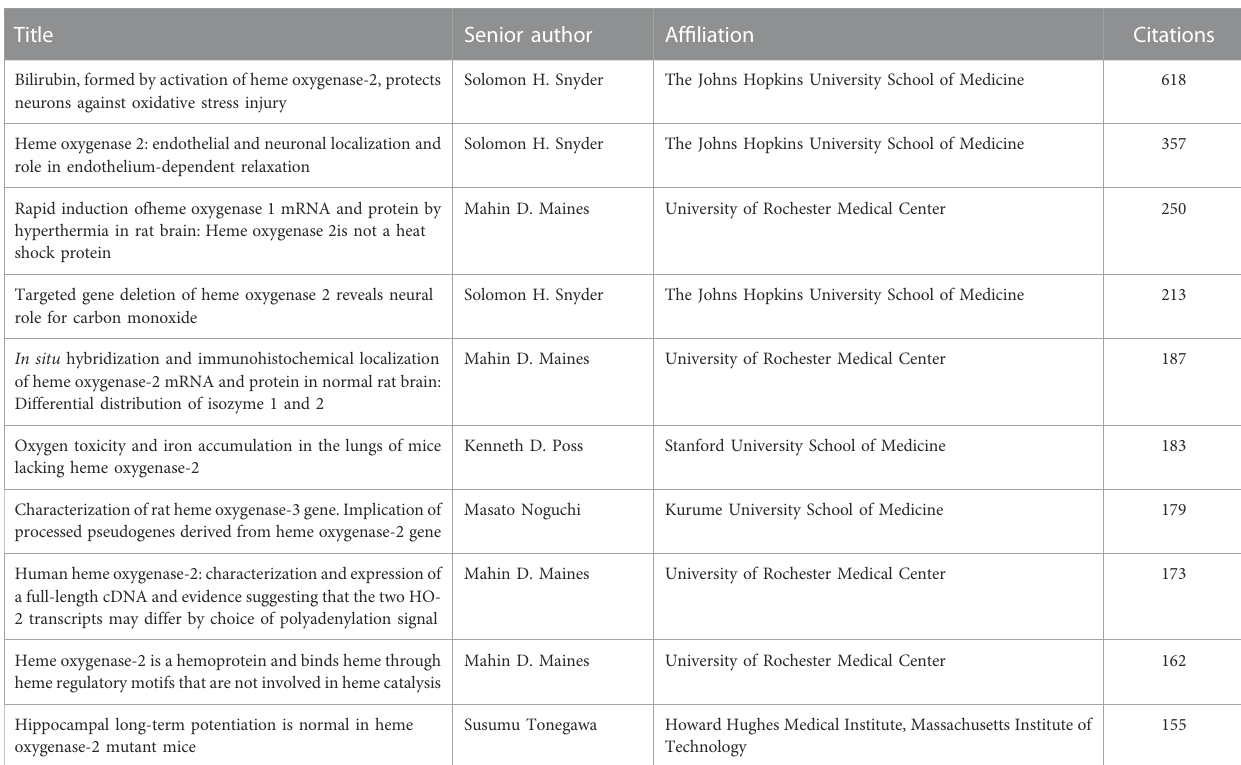
TABLE 3 The top 10 most-cited articles on heme